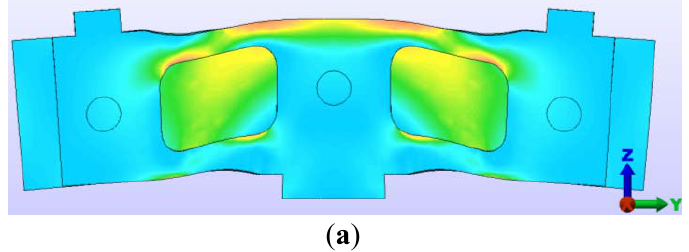
Figure 7. State of main stresses in the deformed sensor module and central elastic